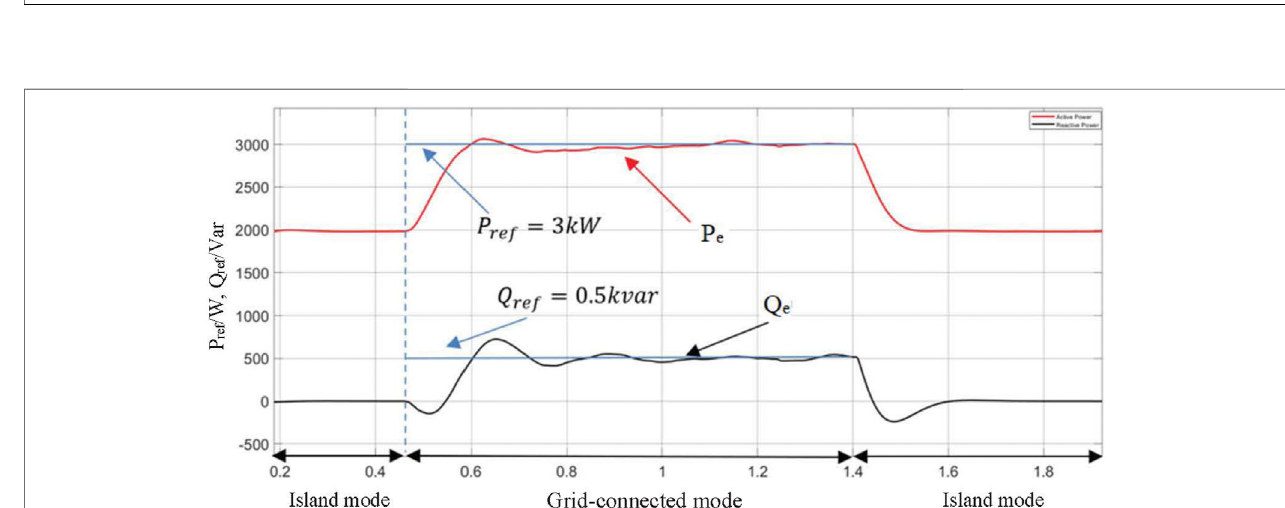
FIGURE 9 | The output active power P e and reactive power Q e of the single-phase VSG.